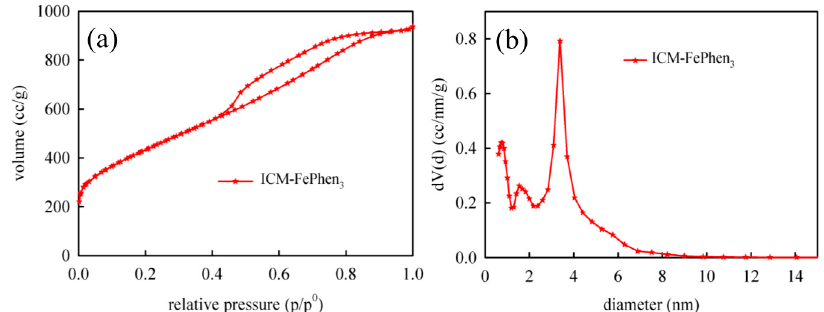
Figure 5. ( a ) N 2 adsorption/desorption isotherm, and ( b ) the corresponding pore size distribution from density functional theory (DFT) method of ICM-derived Fe–N–C catalysts. Table 3. Surface area, pore volume and pore size of ICM-FePhen 3 catalyst based on N 2 physisorption isotherm